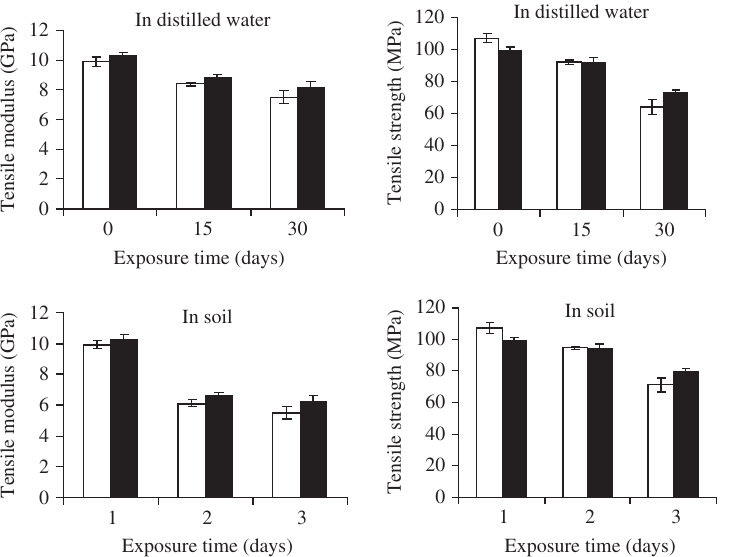
Figure 5 Tensile properties of PBS/hemp composites (white column) and PBS/hemp/clay hybrid composites (black